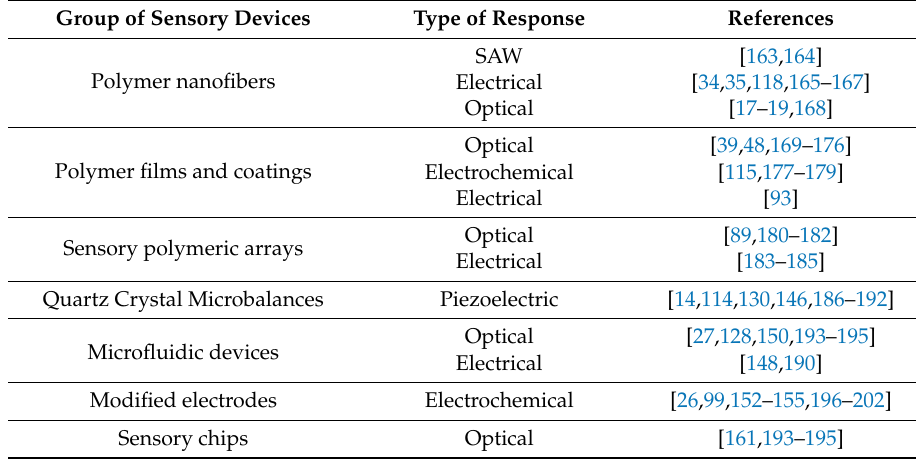
Table 2. Overview of micro and nano sensory devices using smart polymers. (For additional information, please see references